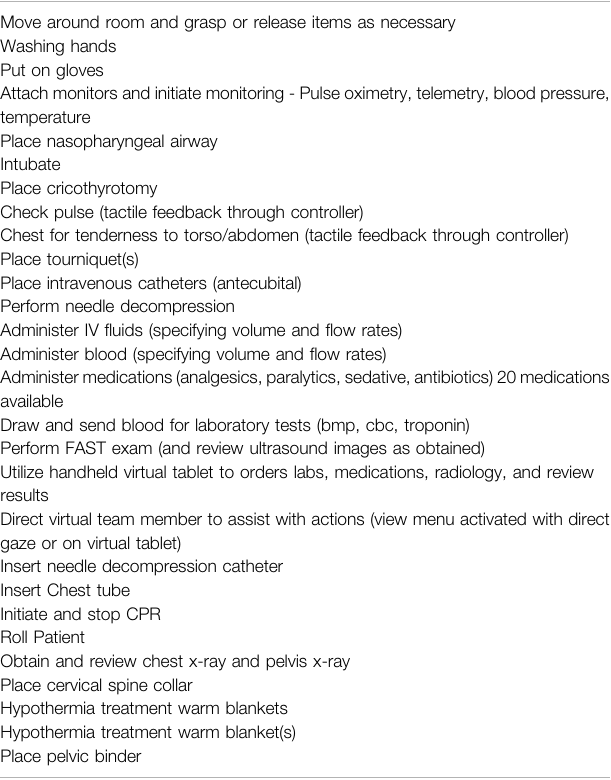
Frontiers in Virtual Reality |